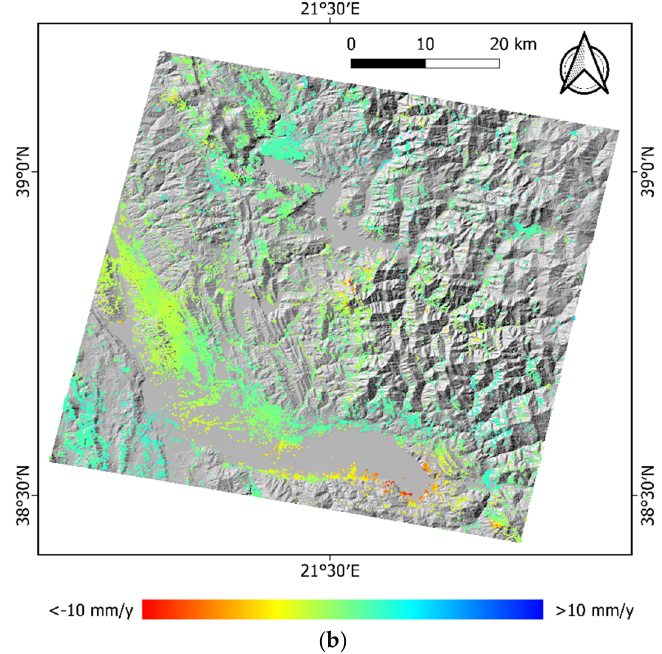
Figure 6. ( a ) ERS 1/2 LOS mean velocities; ( b ) ENVISAT LOS mean velocities.